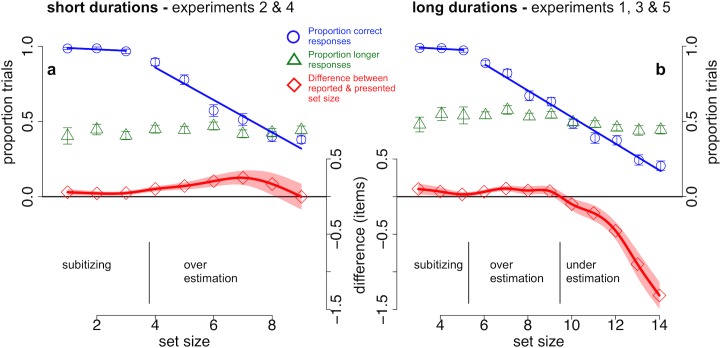
Time and number task performance as a function of set size.The proportion of correct responses (blue circles), proportion of longer responses (green triangles) and difference between reported and presented number (red rectangles) across different set sizes for short stimulus durations (a) and long stimulus durations (b). The proportion of correct responses remained close to ceiling for low set sizes and decreased linearly with every additional item thereafter. Similarly, this subitizing pattern was reflected in negligible differences between reported and presented low numbers (lower axis insets). Enumeration errors predominantly reflect overestimation of intermediate and underestimation of high set sizes (red). The proportion of longer responses (green) remained relatively stable across set sizes. Solid, straight lines show linear fits on the data (blue). Error bars and shaded regions indicate one standard error of the mean (SEM).